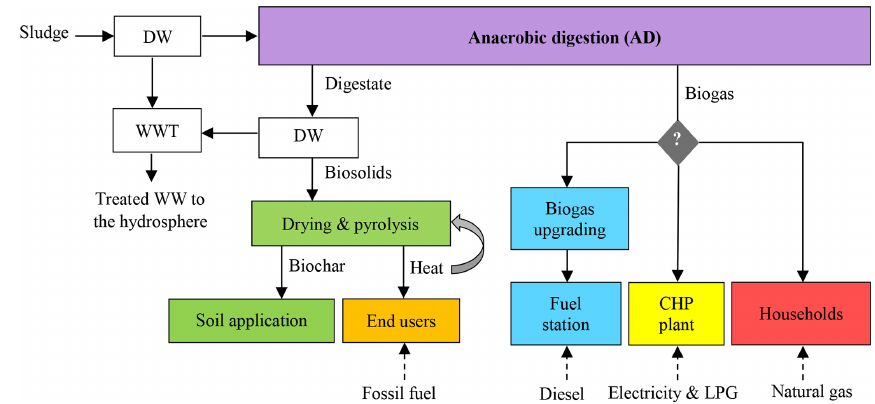
Figure 1. Life cycle diagram for three different uses of biogas, including pyrolysis for digestate management. The DW, WWT, LPG and CHP represent the dewatering, wastewater treatment, liquefied petroleum gas and combined heat and power respectively. The biochar is assumed to be incorporated into unfertilized forest